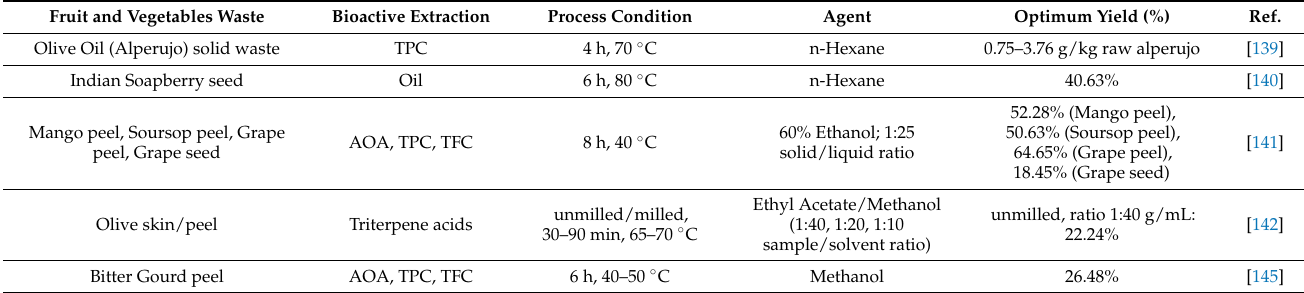
Table 5. Progress studies of FVW in the application of Soxhlet